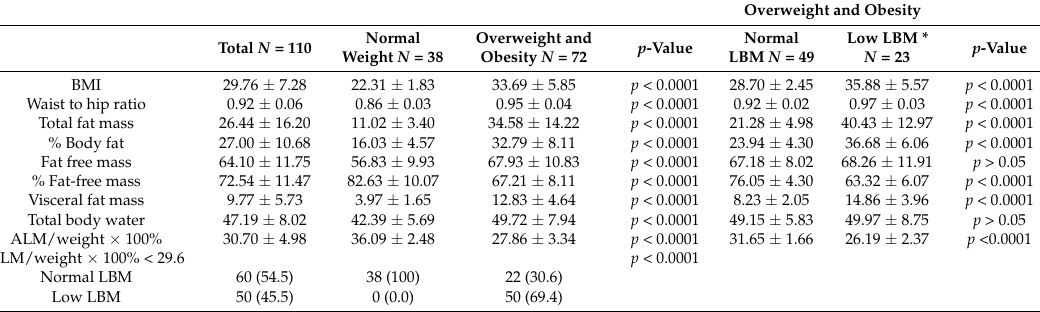
Table 4. Anthropometric characteristics and body composition patterns by BMI status and category of low